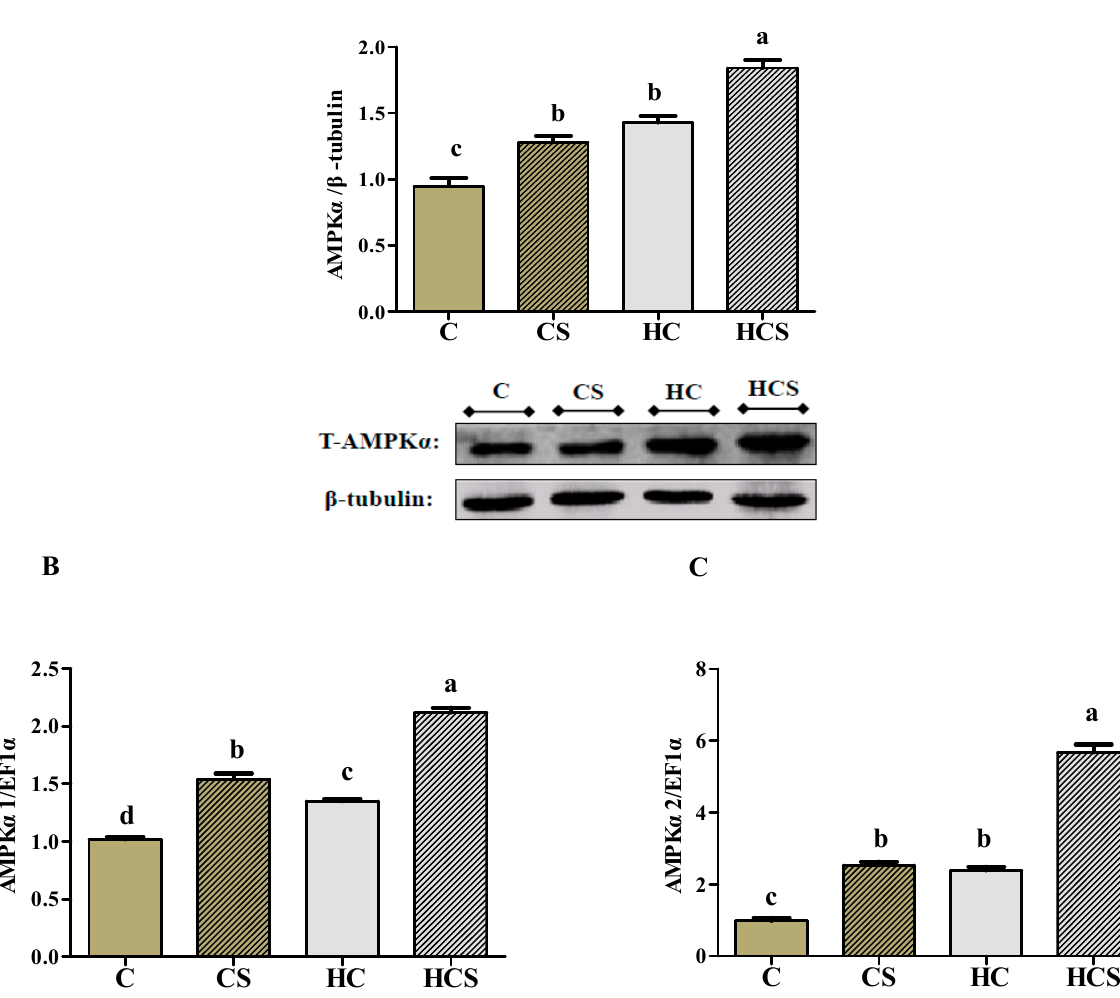
Figure 4. Hepatic content of T-AMPK α protein ( A ), transcriptions of AMPK α 1 ( B ), AMPK α 2 ( C ) M. amblycephala subjected to different treatments. Gels were loaded with 20 mg total protein per lane. Each data point represents the means ± SEM of four replicates. Bars assigned different superscripts (a, b, c and d) are significantly different ( p < 0.05).